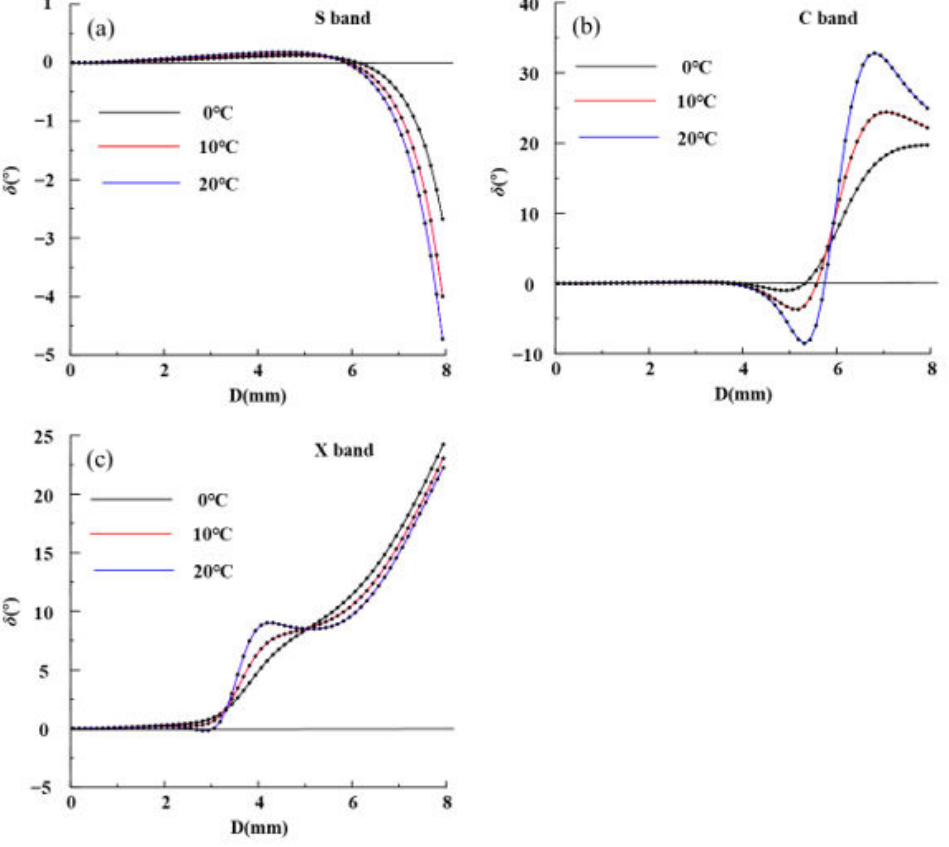
Figure 1. The relationship between δ and raindrops’ equivalent diameter for ( a ) S-, ( b ) C-, and ( c ) X-band at different